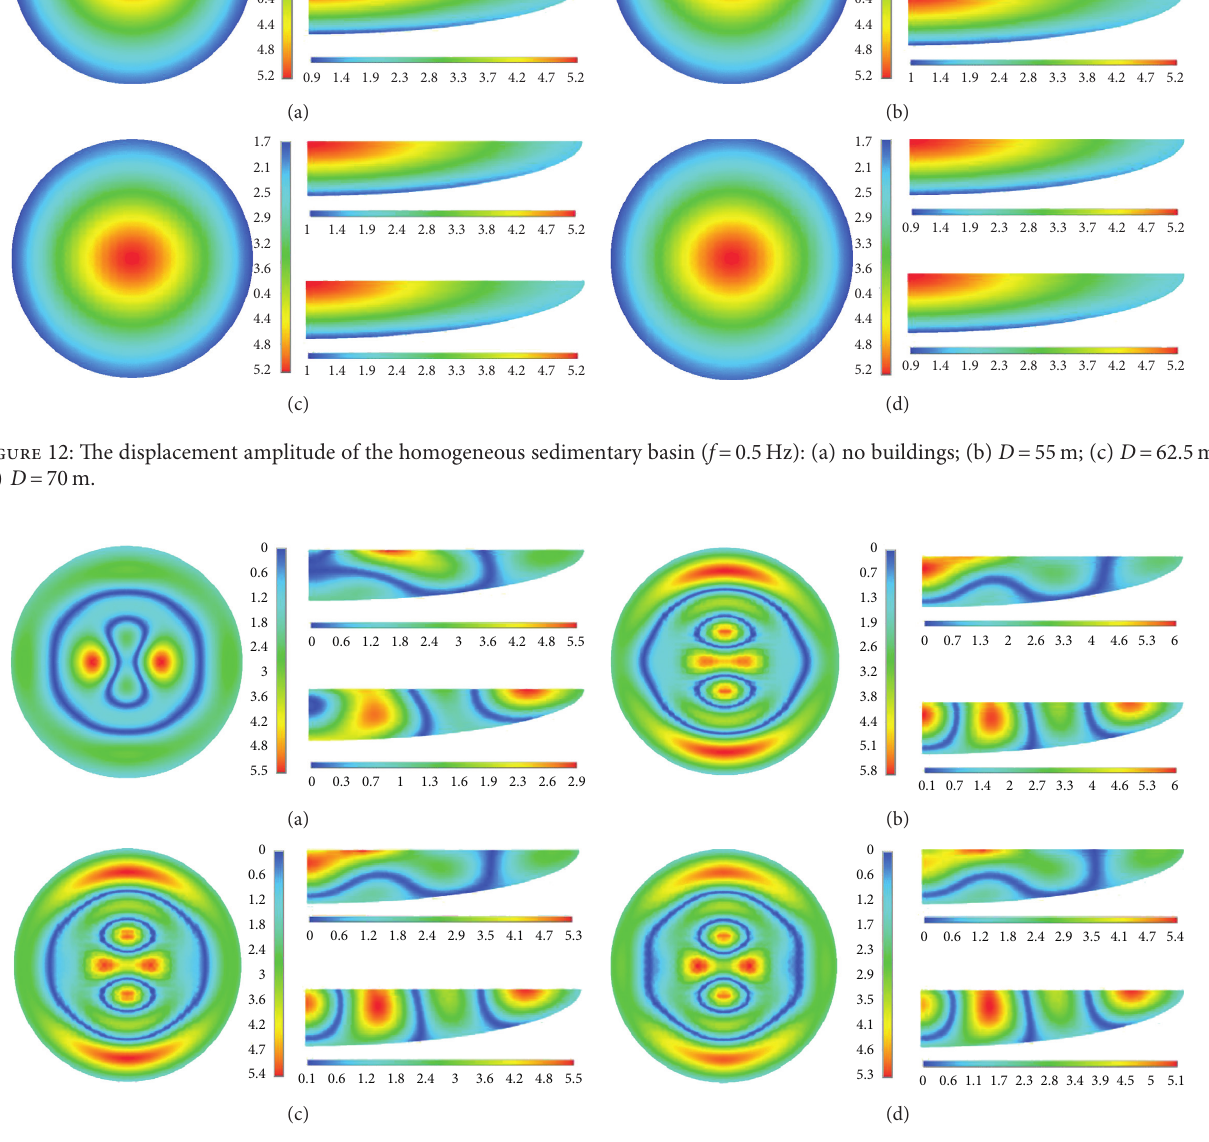
Figure 13: The displacement amplitude of the homogeneous sedimentary basin ( f � 1.0Hz): (a) no buildings; (b) D � 55m; (c) D � 62.5m; (d) D � 70